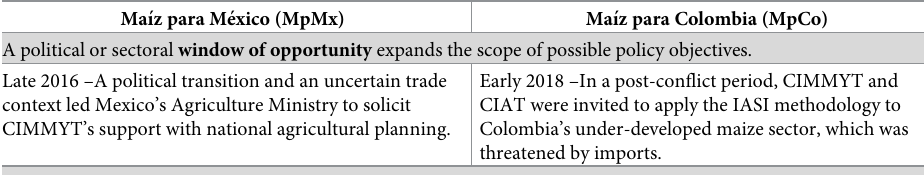
Table 1. Development and adaptation of the Integrated Agri-food System Initiative through application to maize-based systems in Mexico and